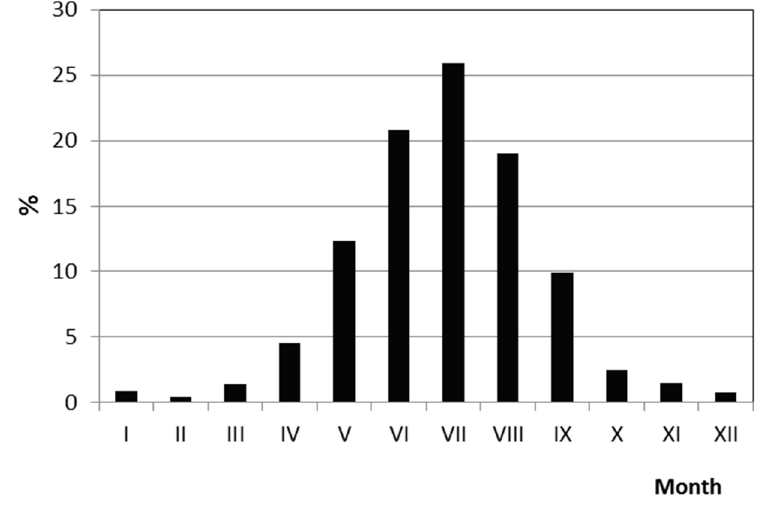
Figure 3. Frequency (%) of the annual maximum daily precipitation over the year